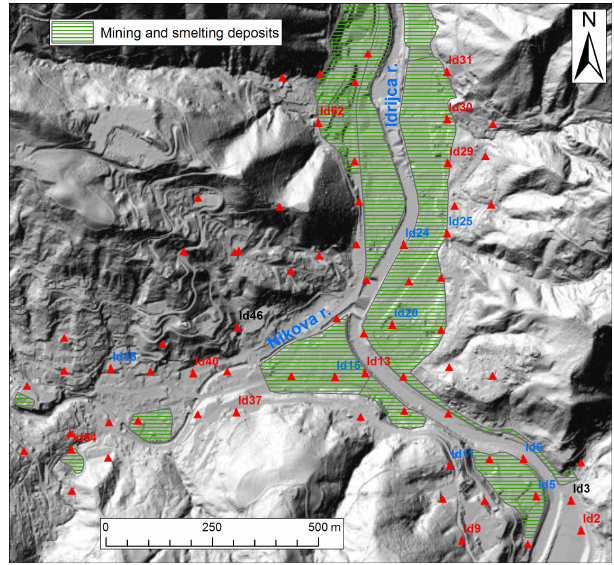
Figure 2. Position map of microtremor measurements (red trian- gles) in the Idrija town area. Red labeled points indicate examples of HVSR analyses shown in Fig. 5, blue labeled points examples shown in Fig. 6, and black labeled points examples shown in Figs. 3 and 4. Extent of mining and smelting deposits is shown (data pro- vided by Idrija municipality). Basemap shaded relief was derived from lidar 1m resolution digital elevation model (Ministry of the Environment and Spatial Planning, portal